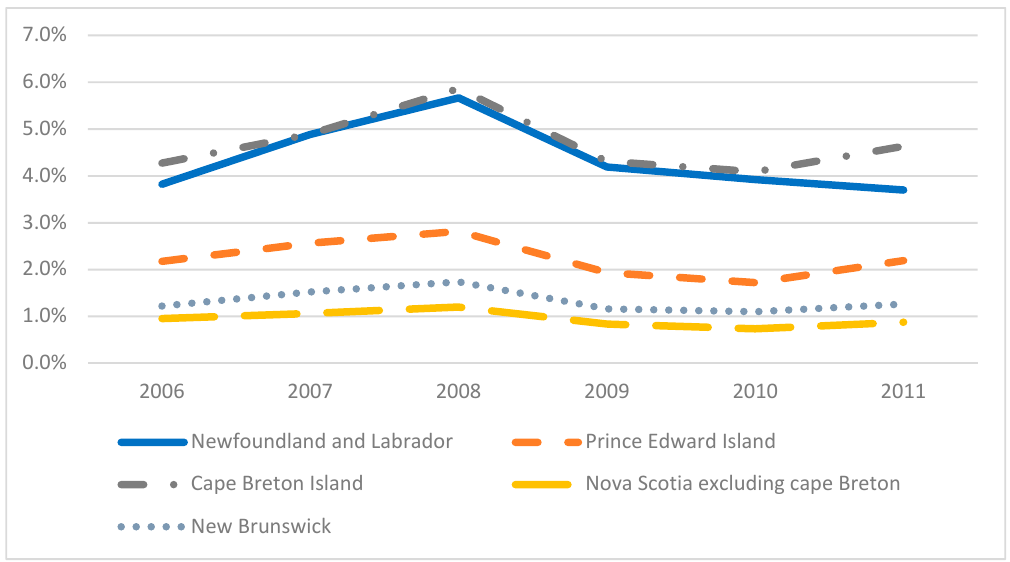
Figure 4. Number of inter-provincial employees in Alberta as percentage of labour force by province of residence, 2006 to 2011.